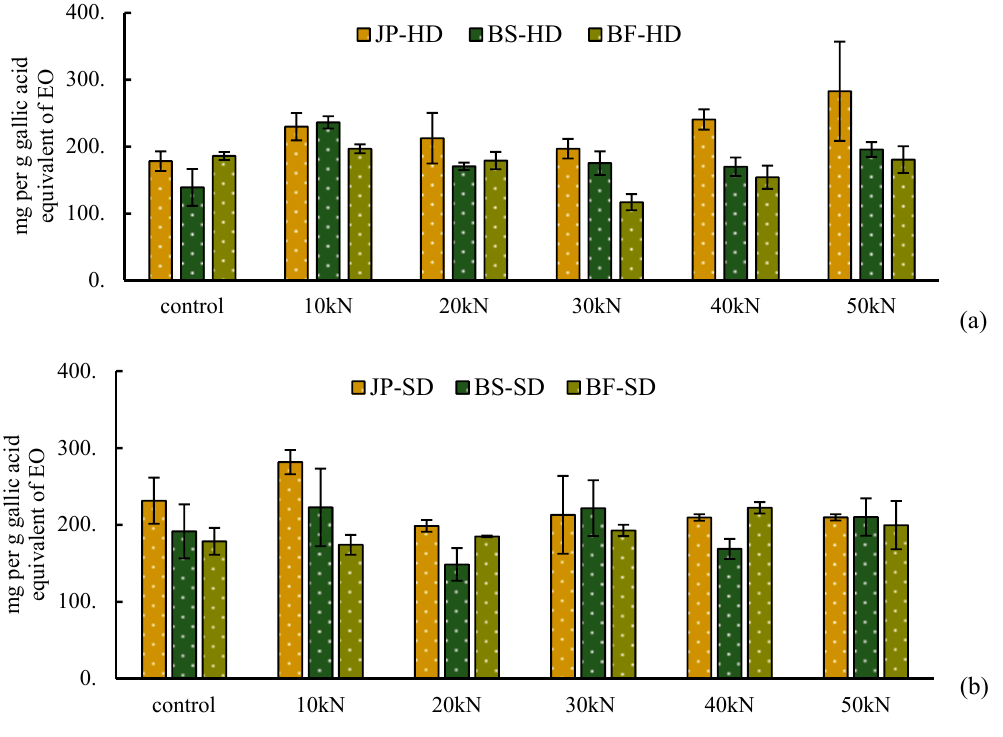
Figure 5. E ff ect of compression level (10 − 50 kN), species type (BF, BS, and JP), and extraction method—( a ) hydrodistillation (HD) and ( b ) steam distillation (SD)—on total phenol content.